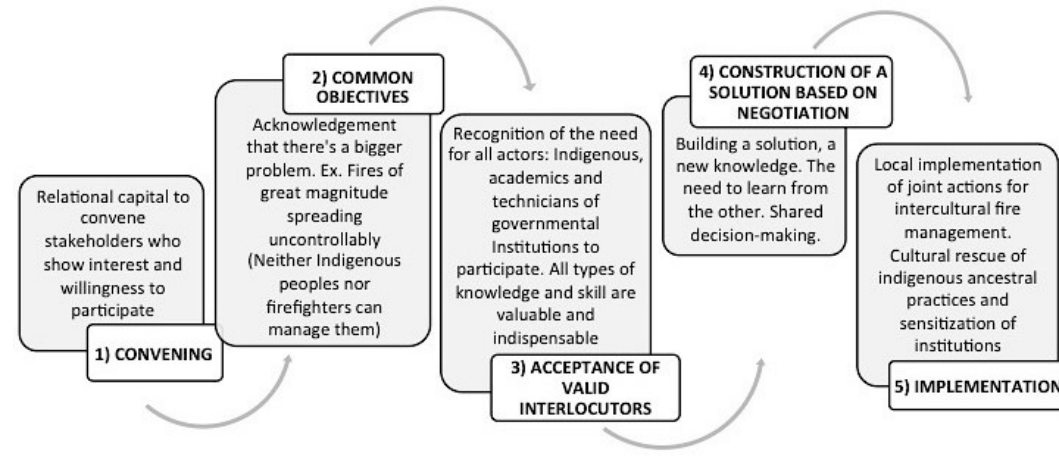
Figure 3. Intercultural fire management agreement process model.